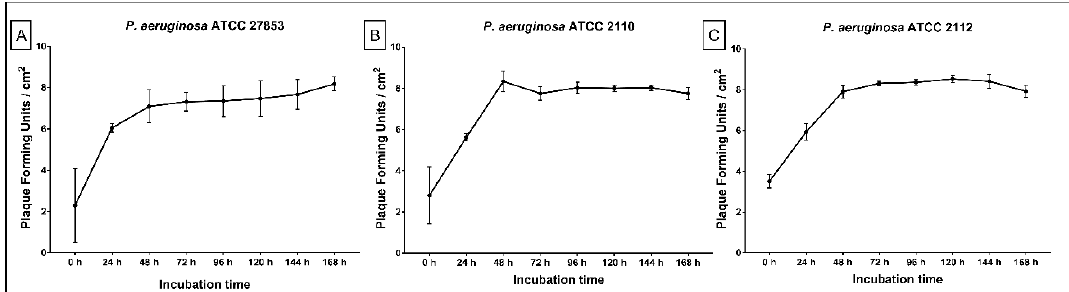
Figure 2. Phage cocktail presence on tube surfaces over 24 to 168 h of dynamic biofilm growth. ( A ) P. aeruginosa ATCC 27853; ( B ) P. aeruginosa ATCC 2110; ( C ) P. aeruginosa ATCC 2112.